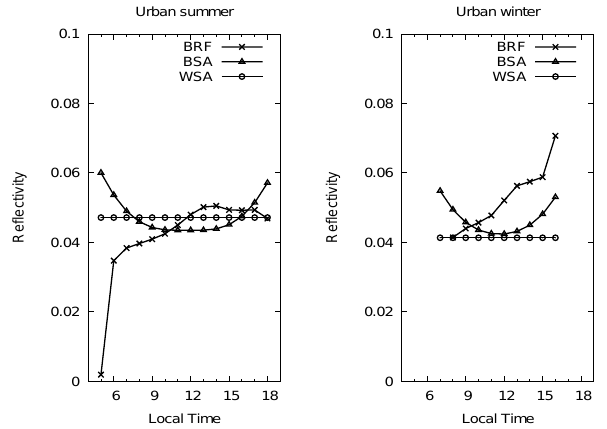
Figure 8. Reflectivity values of BRF, BSA, and WSA, which are Fig. 8. Reflectivity values of BRF, BSA and WSA, which are implemented as LER in the RTM, in summer (left)andwinter(right). Theresultsfortheurbansurfacetypeareshown. implemented as LER in the RTM, in summer (left) and winter (right). The results for the urban surface type are